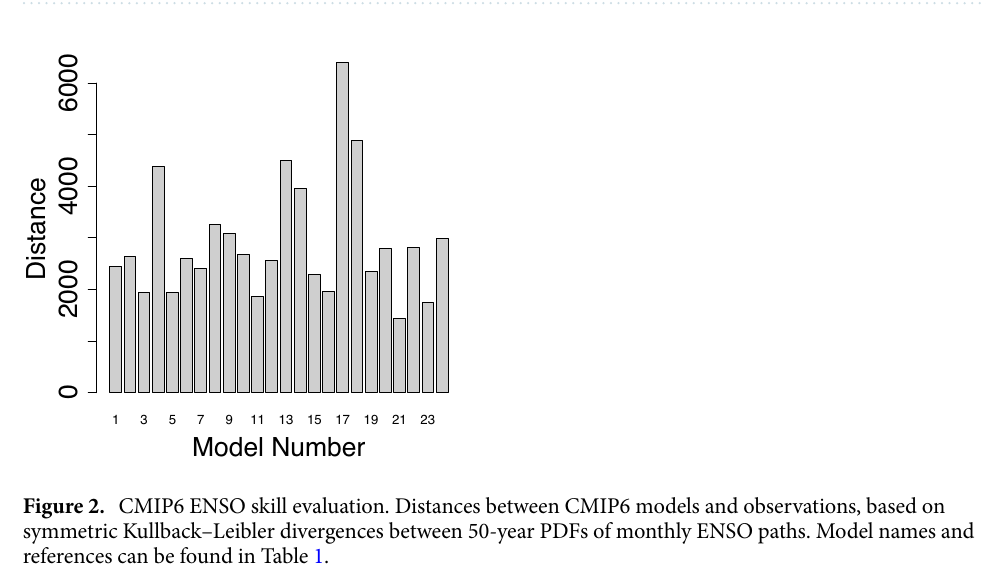
Figure 1. Workflow of the multi-model projection method. t refers to monthly Niño 3 temperatures, and h refers to monthly equatorial mean thermocline depths. Blue rectangles represent information derived from CMIP6 models; red rectangles represent information derived from observations. Black rectangles show information derived from the fusion of both sources of information.